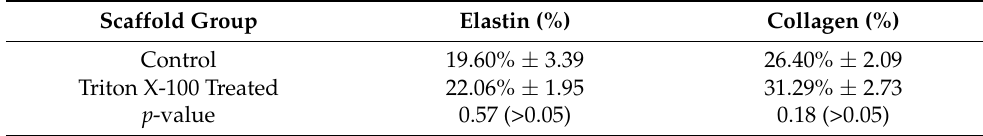
Table 1. Average % ± SEM of elastin and collagen on control and decellularized scaffolds. It was found that there was no significant difference ( p > 0.05) in elastin and collagen amounts between the two groups.